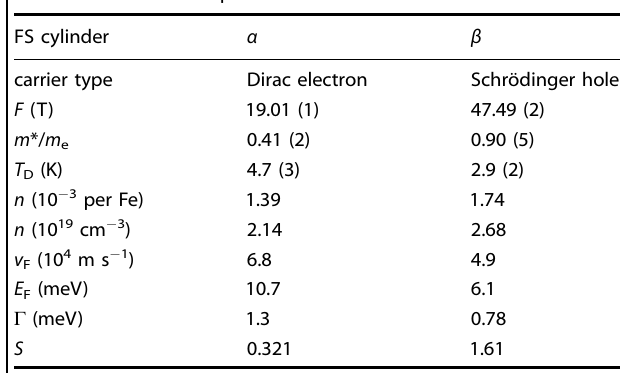
Table 1. Fermi-surface parameters.